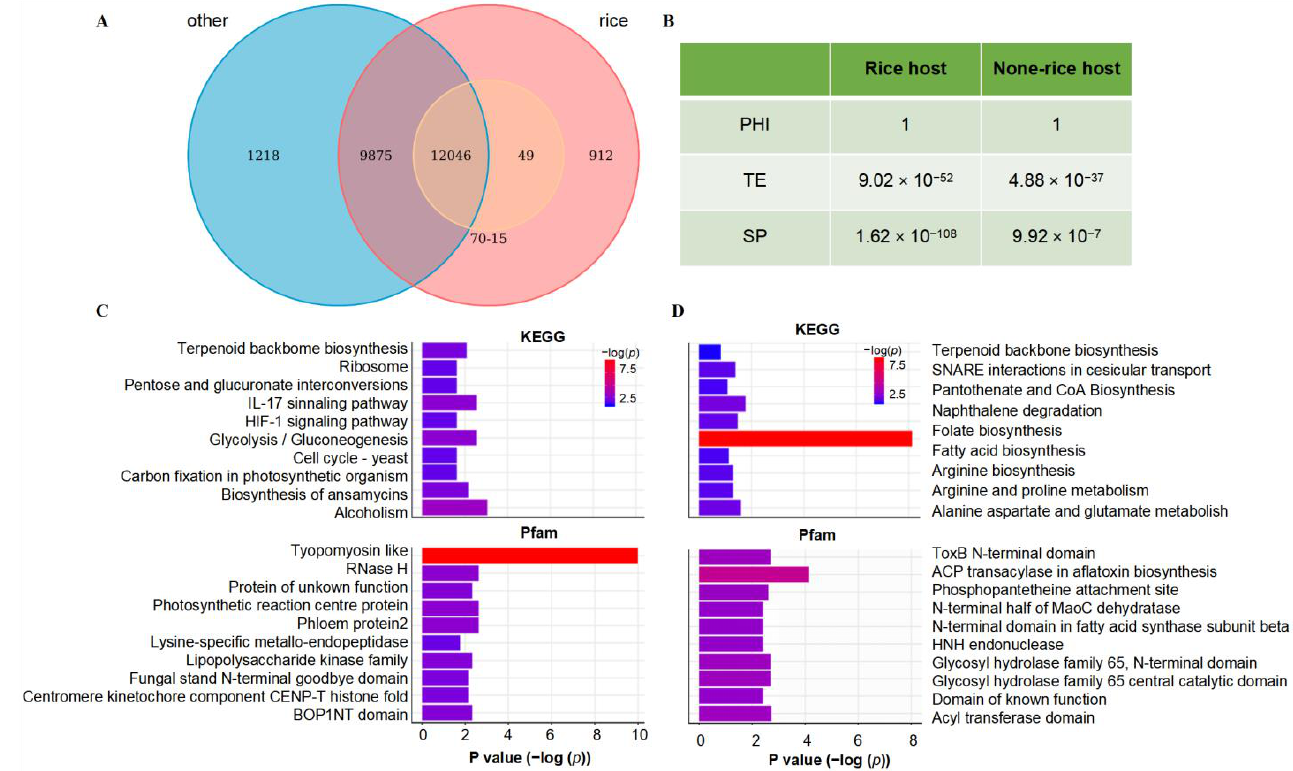
Figure 3. Functional enrichment analysis of new genes in pan-genome. ( A ) Comparative analysis of pan-genes from different hosts and the reference genome 70-15. ( B ) Association analysis of the new pan-genes from different hosts with Pathogen Host Interactions (PHI), TE and secreted proteins. ( C ) Functional enrichment analysis of new genes in rice-infecting strains. ( D ) Functional enrichment analysis of new genes in non-rice-infecting strains.